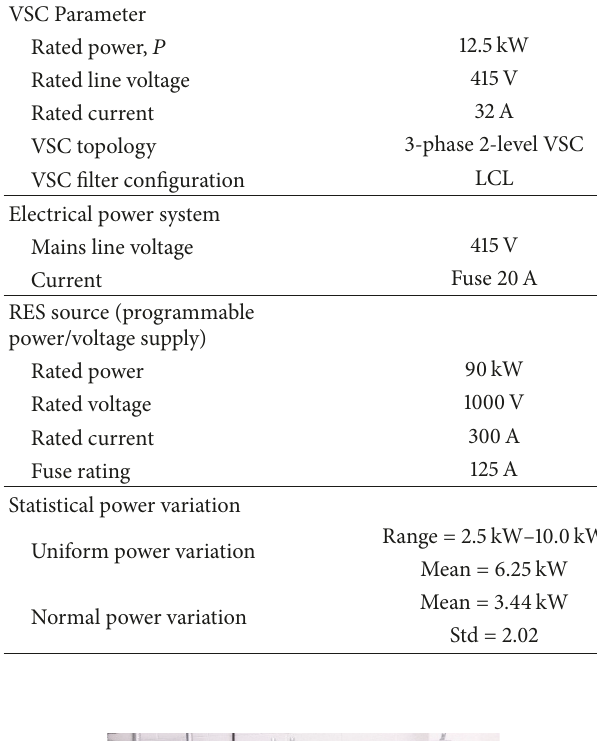
Table 1: Microgrid and VSC laboratory parameters.